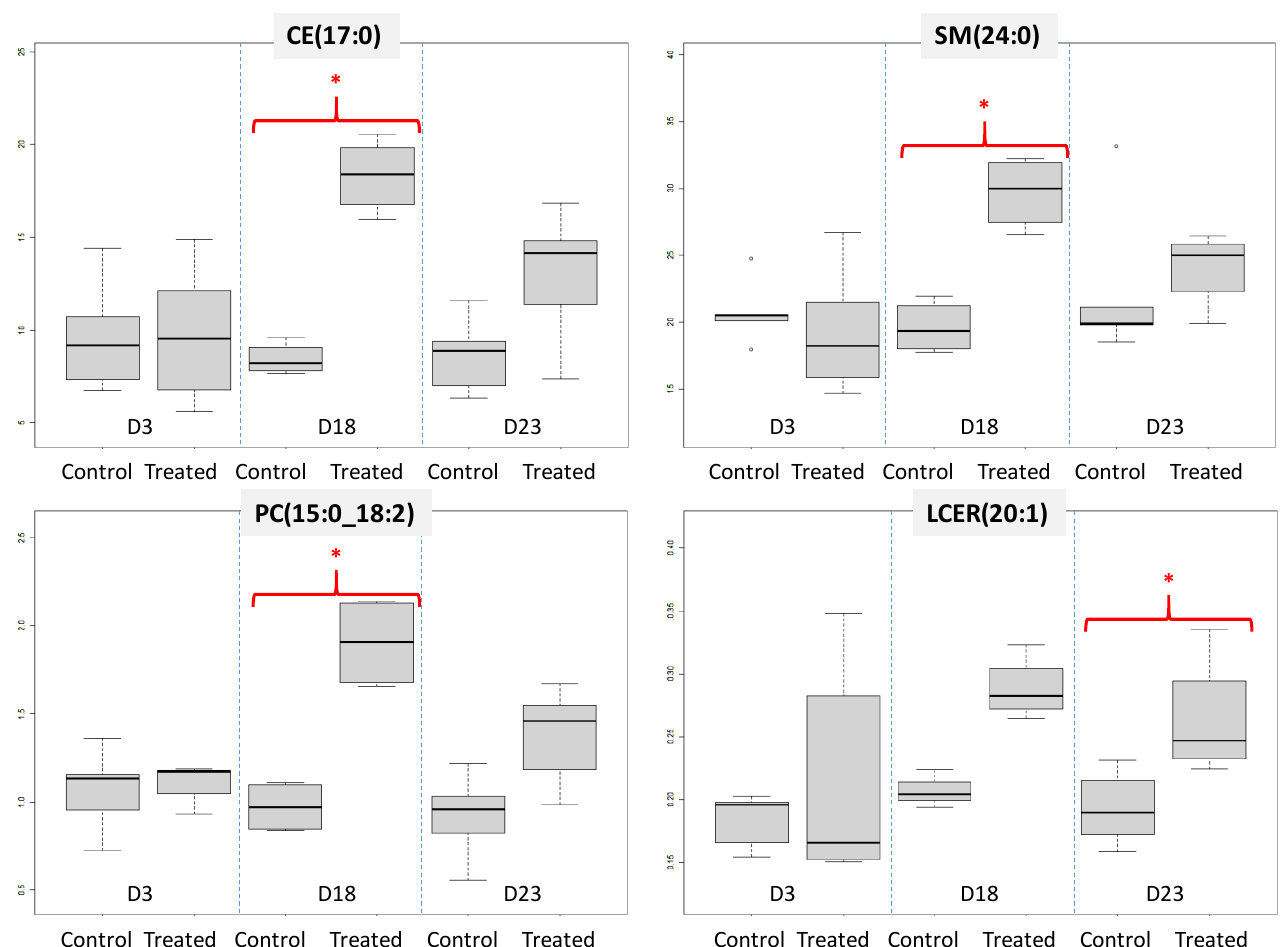
Figure 2. Comparison of estimated concentration (nmol · g − 1 ) from four lipid species analysed with Lipidyzer™ between the two animal groups of interest, and for different serum collection points. Here, the quantification cannot be considered as accurate (hence “estimated”) since it is has not been validated on pig serum, as opposed to human. *: p -value ≤ 0.05.